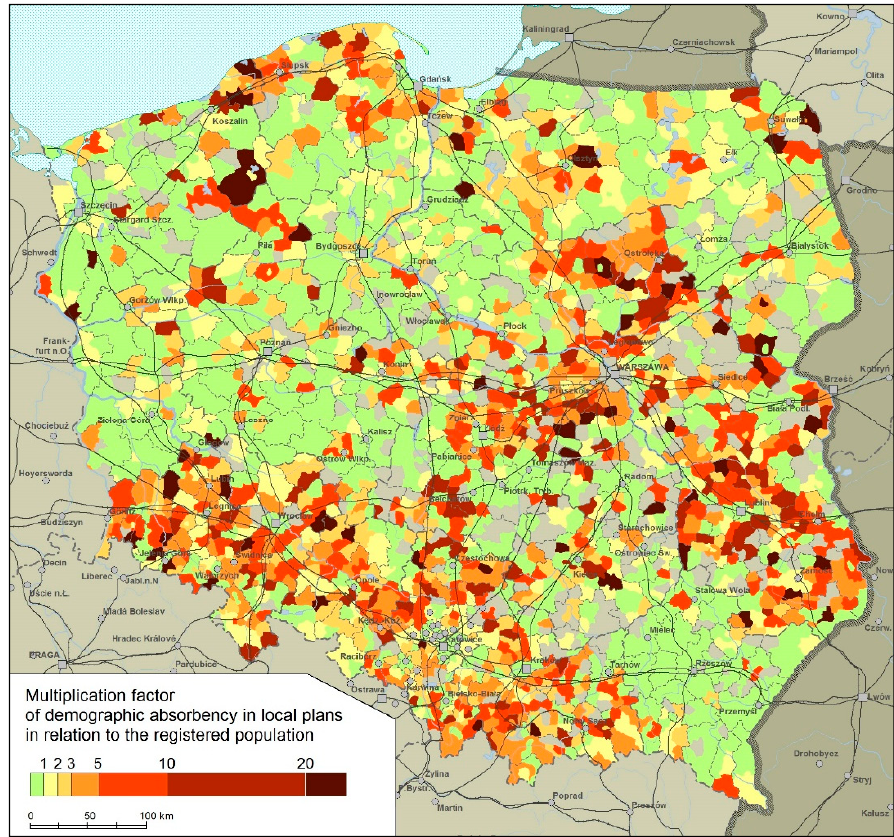
Figure 5. Multiplicity of demographic absorbency according to the local plans in relation to the registered number of inhabitants. Source: [77].